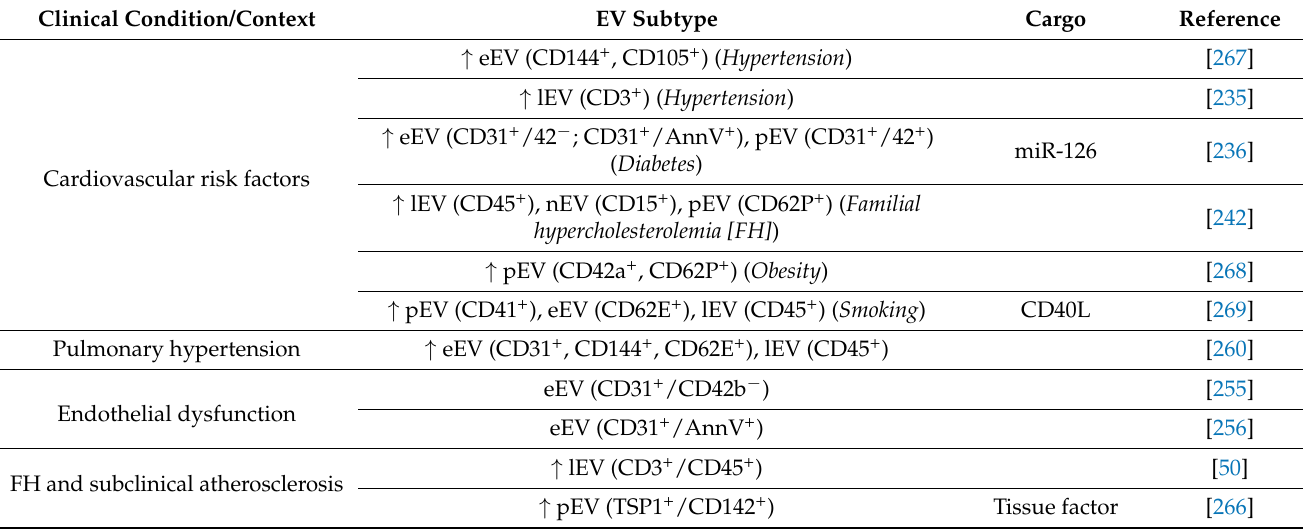
Table 1. Extracellular vesicles (EVs) as potential markers of ASCVD diagnosis and prognosis. Studies showing EV changes in distinct ASCVD risk factors and